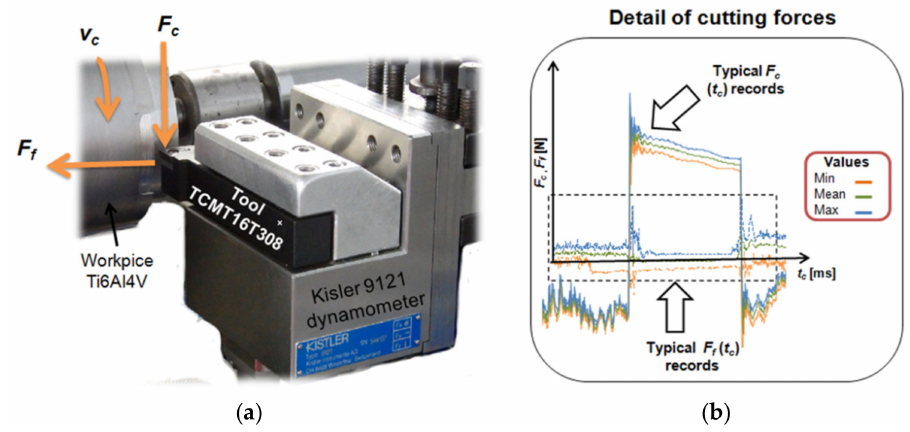
Figure 2. ( a ) Cutting force acquisition system; ( b ) typical signals F c ( t c ) and F f ( t c